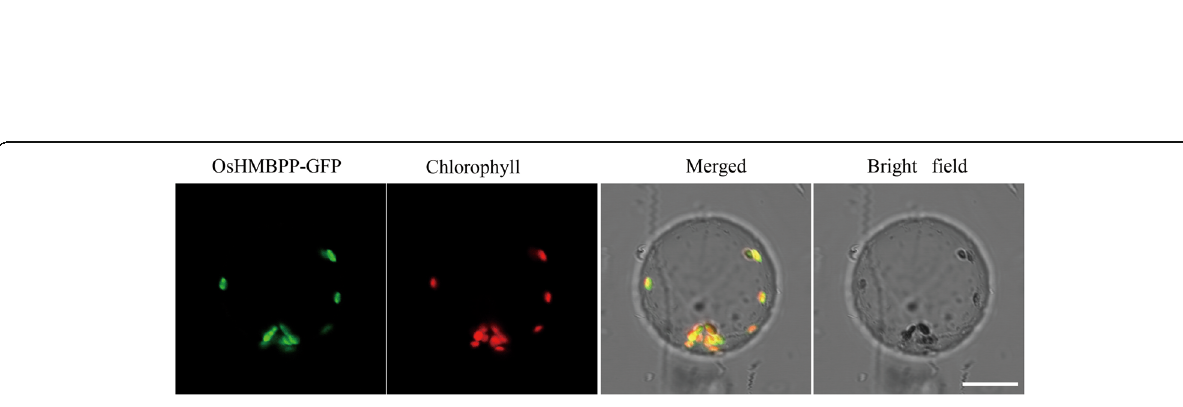
Fig. 5 Subcellular location of the OsHMBPP protein. GFP signals of OsHMBPP-GFP fusion protein was located in the chloroplasts by transient expression analyses in rice protoplasts. Green fluorescence shows GFP, red fluorescence shows chloroplast autofluorescence, and yellow fluorescence shows the merged